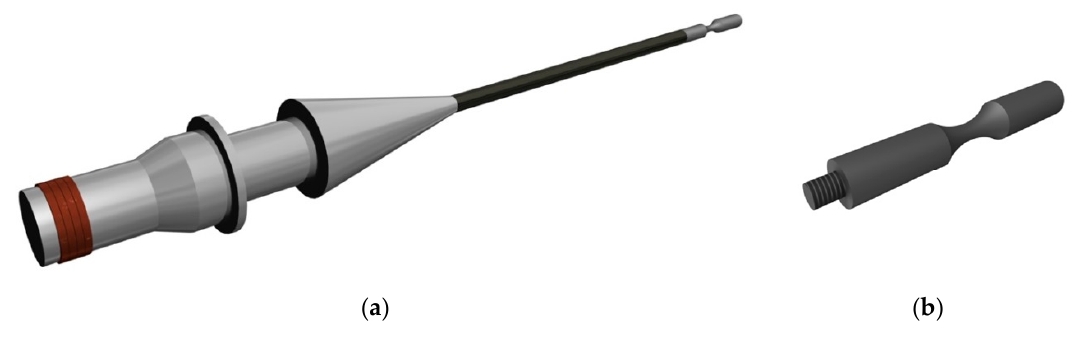
Figure 8. Parts of the experimental ultrasonic resonance device for internal friction measurement. ( a ) Electromechanical part of the apparatus. ( b ) The test bar for the measurement of the damping measurements.